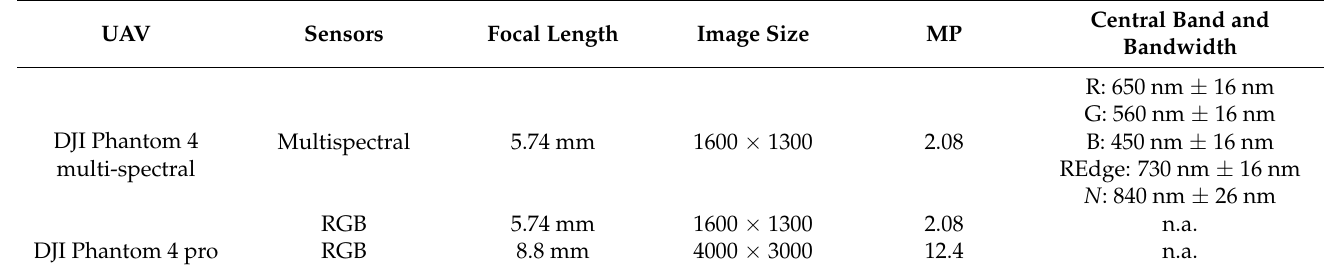
Table 2. UAV-embedded sensors‘